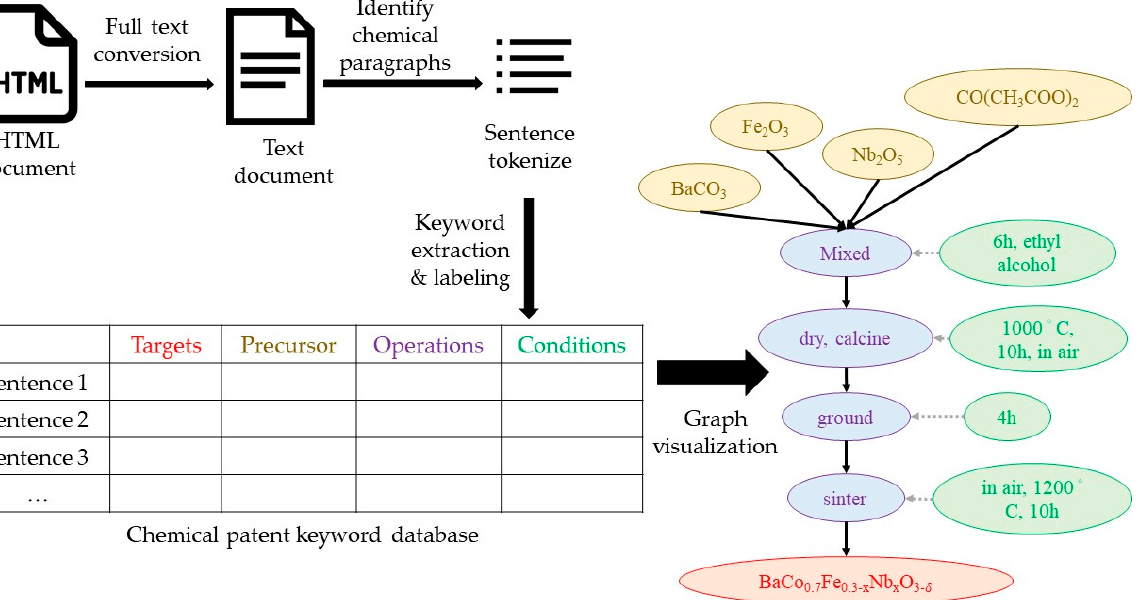
Figure 5. The system framework of computer-supported chemical patent knowledge graph generation.